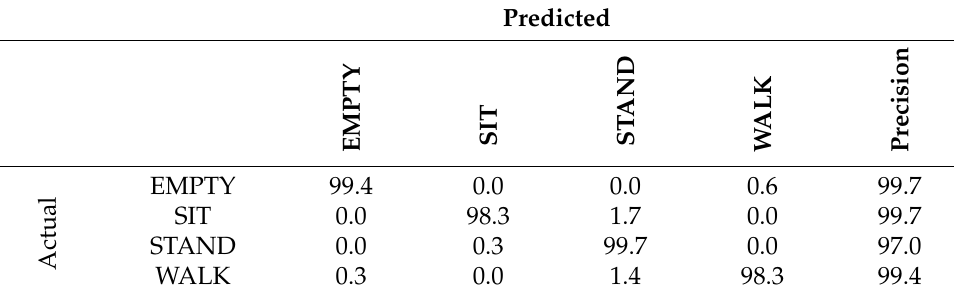
Table 5. LSTM HAR classification with denoised for Experiment